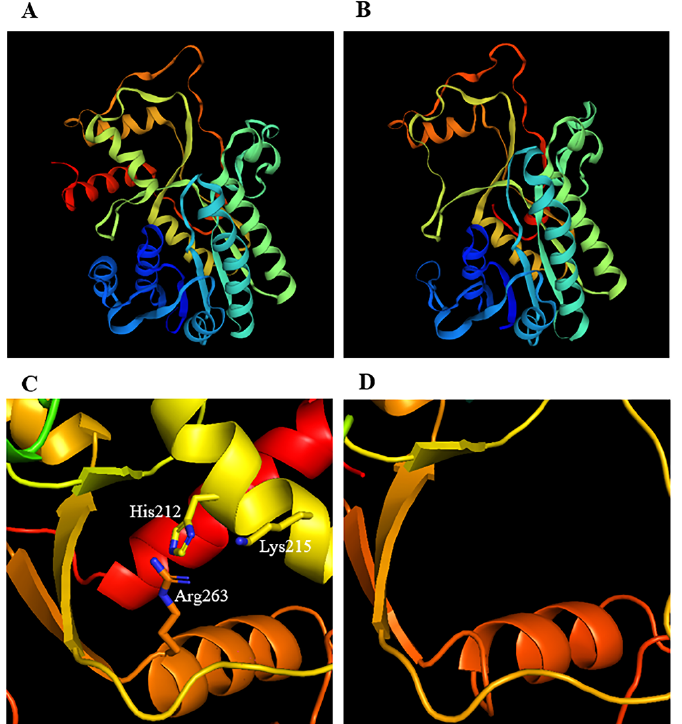
Figure 7. The predicted three-dimensional structure of MsCCR1 ( A ) and MsCCR-like1 ( B ), and the detailed structure in the C-terminal end of MsCCR1 ( C ) and MsCCR-like1 ( D ). The spirals, arrows, and lines indicate the α -helices, β -sheets, and turns and coils, respectively. The sticks indicate catalytic triads H212(X)2K215R263 with corresponding.